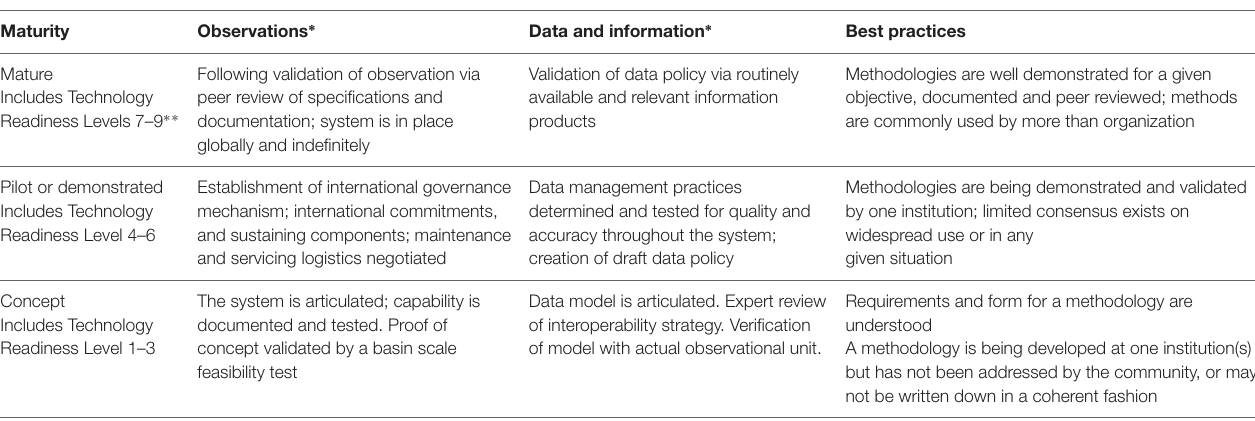
FIGURE 3 | Tagging documents using marine related ontologies enhances best practice discovery. Documents are submitted to the repository and text in the document is sent to the tagging module, which identifies tagged words by comparing with marine and other ontologies and then transmits the results for access by users. TABLE 1 | Definitions of maturity levels for ocean best